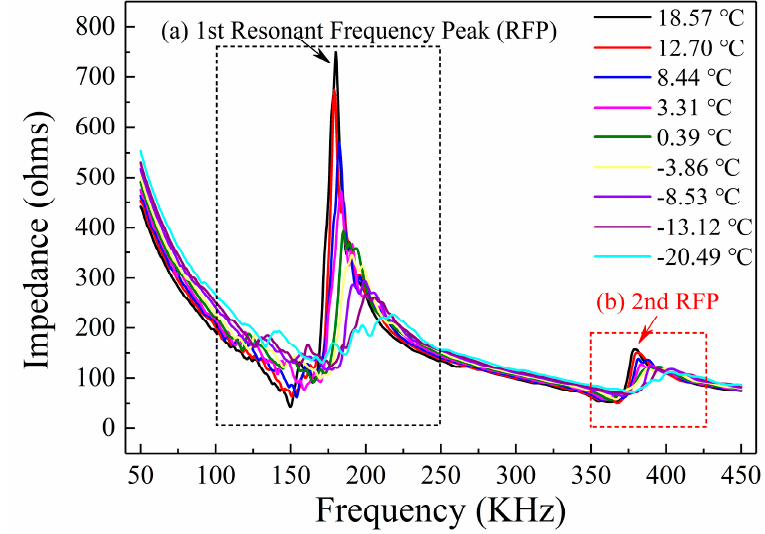
Figure 5. Impedance variation during the soil freezing process: ( a ) the first observed resonant frequency peak (RFP); ( b ) the second observed resonant frequency peak.